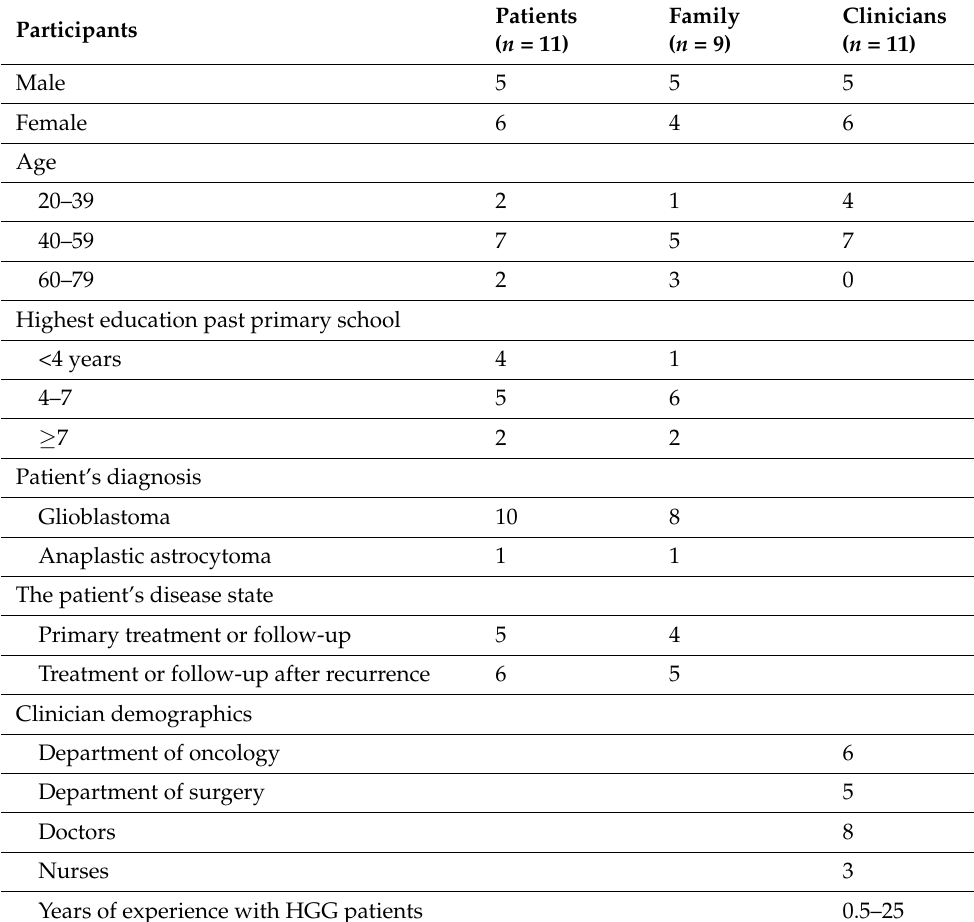
Table 1. Demographic characteristics of participants in the alpha